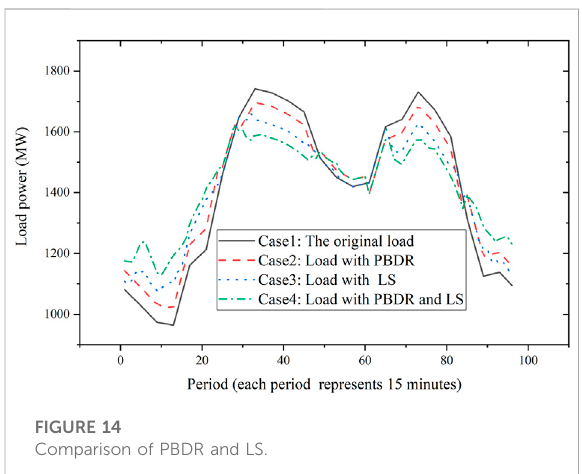
FIGURE 14 Comparison of PBDR and